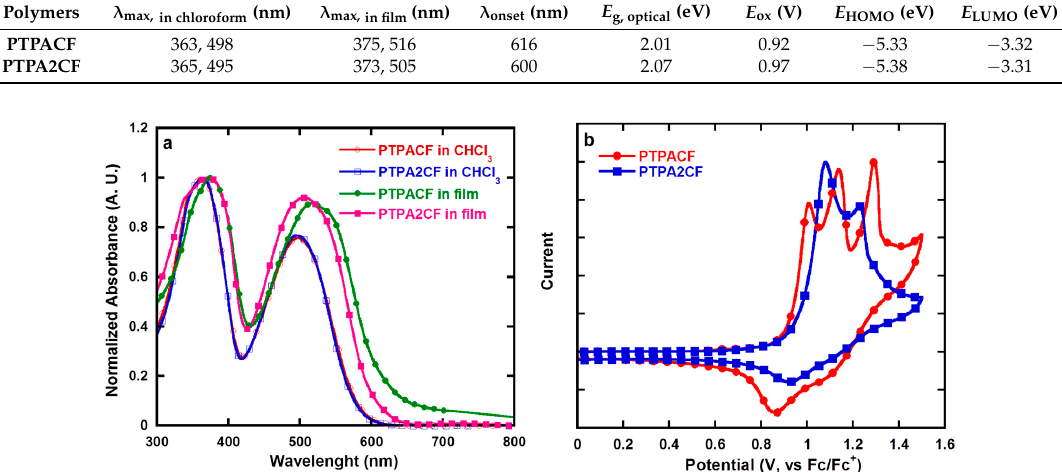
Table 2. Summary of UV-vis absorption and electrochemical properties.